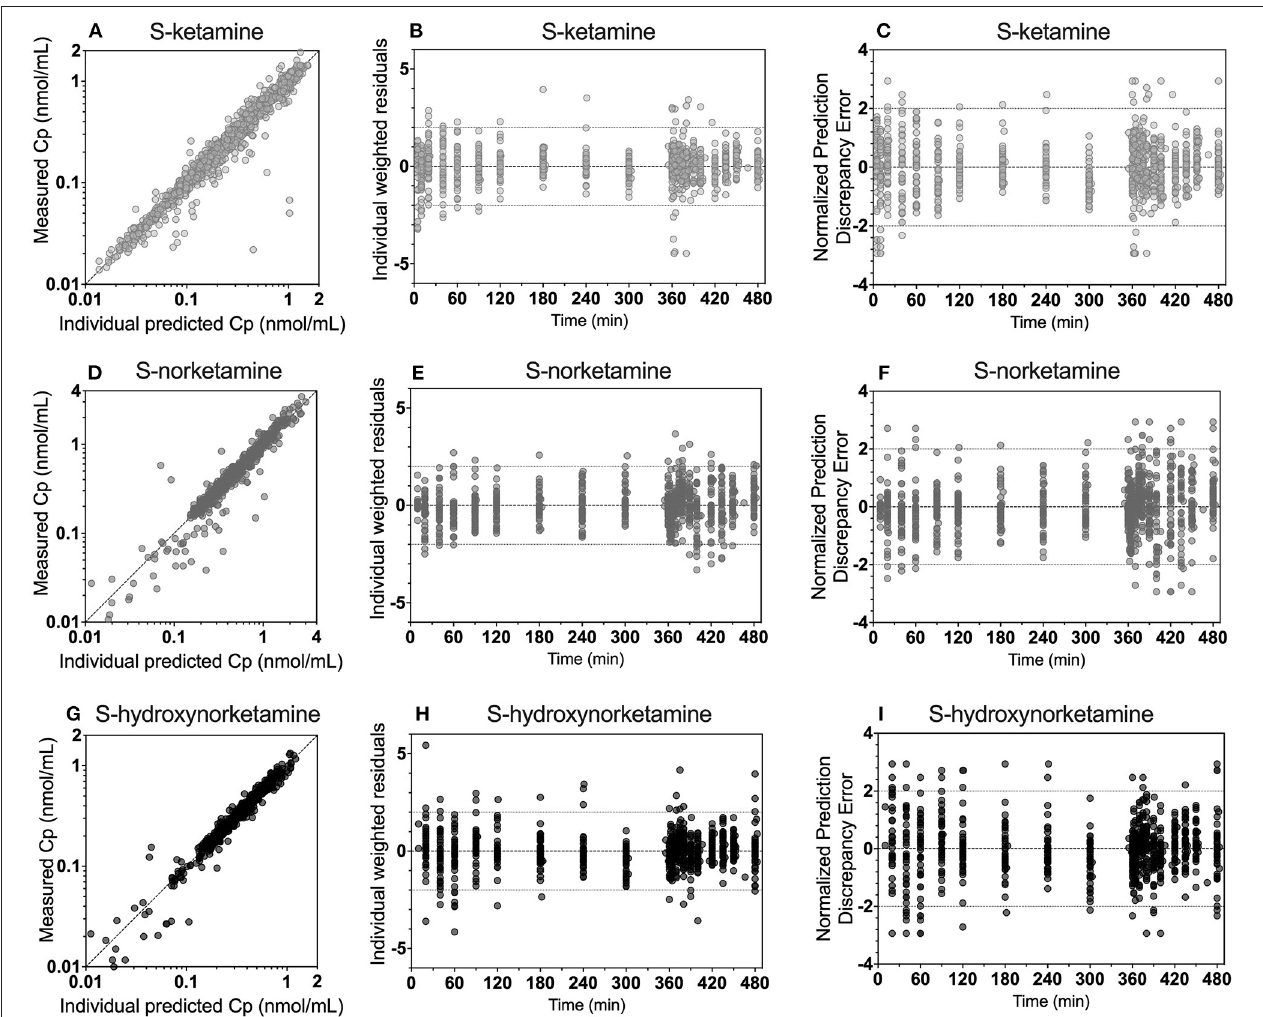
FIGURE 3 | Goodness-of-fit plots for S- ketamine (A–C) , S- norketamine (D–F) and S- hydroxynorketamine (G–I) . (A , D,G) : measured concentration vs. individual predicted. (B,E,H) : individual weighted residuals vs. time. (C,F,I) : Normalized discrepancy errors vs. time.